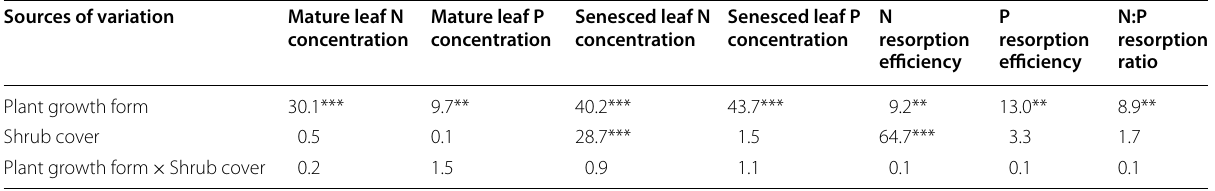
Table 2 Effects of plant growth form and shrub cover on leaf nutrient resorption parameters in freshwater wetlands of Northeast China